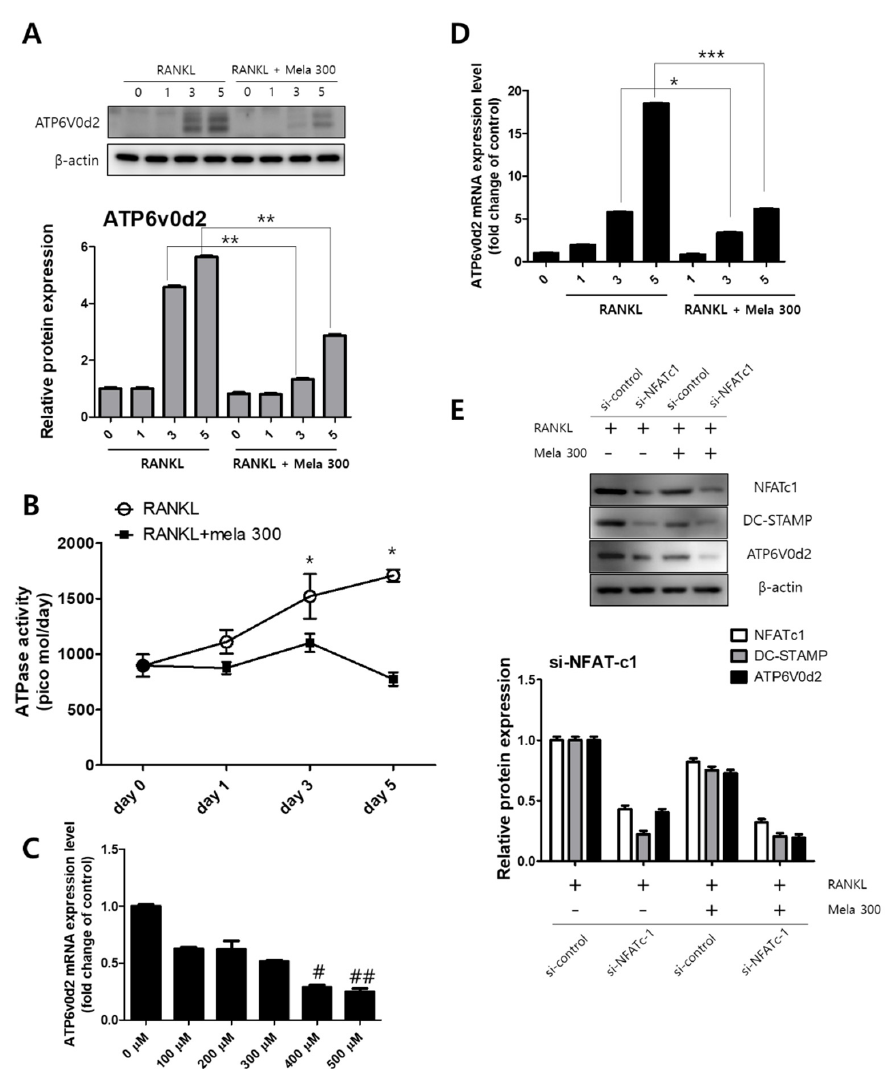
Figure 5. Regulation of V-ATPase (Atp6v0d2) expression following ( A , D ) treatment of RAW264.7 cells with RANKL and RANKL + melatonin for 1, 3, and 5 days. ( A ) Graph of Atp6v0d2 expression according to western blotting. ( D ) mRNA expression of Atp6v0d2 according to real-time PCR. Values represent the means of three independent experiments ± SDs RANKL alone treatment and RANKL + melatonin combination treatments were verified using a paired sample t-test (* p < 0.05, ** p < 0.01, and *** p < 0.001). ( B ) ATPase activity was conducted in RAW264.7 cells treated with RANKL (10 ng/mL) and melatonin (100 to 500 µ M) for 1 to 5 days and ( C ) Atp6v0d2 gene expression of RAW264.7 cells treated with RANKL (10 ng/mL) + melatonin (100 to 500 µ M) for 24 h. ( E )